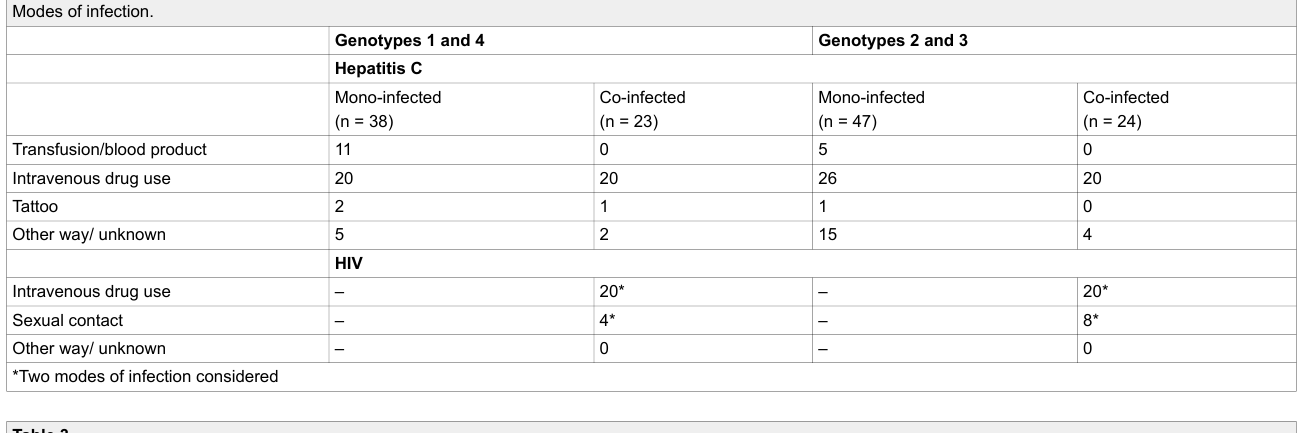
Table 3 Positive predictive value of an SVR with undetectable HCV-RNA at week 4 and week